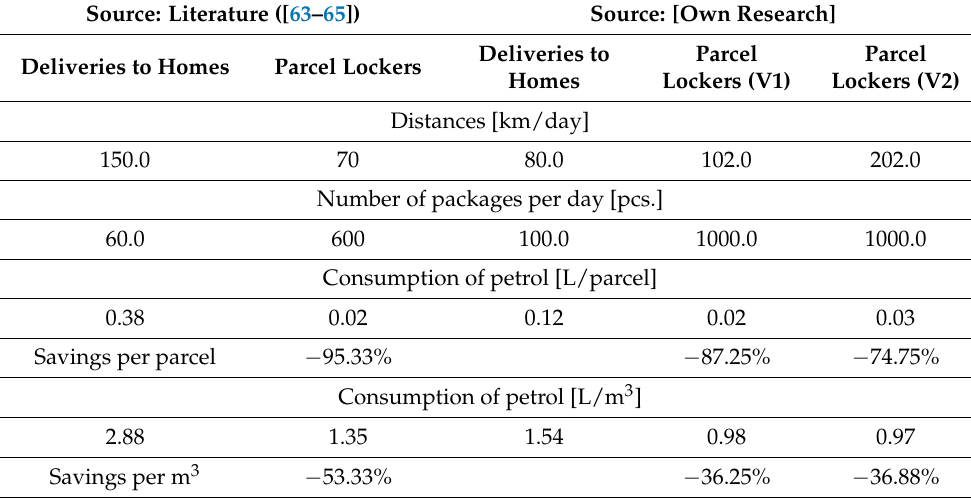
Table 3. Comparison of efficiency of consumption of fuel of two distribution channels in